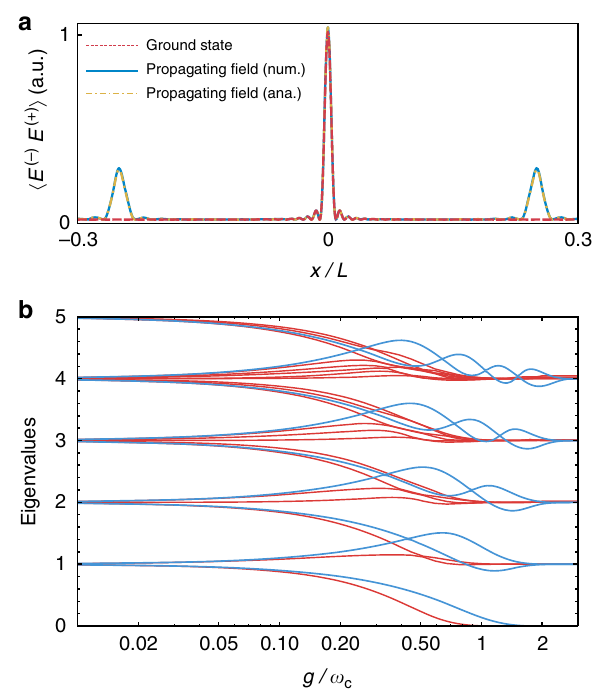
Fig. 4 Ground state and eigenvalues of the multi-mode Rabi model. a Red, dashed line: Amplitude of the electric fi eld inside the cavity corresponding to the ground state of the system for g / ω c = 0.6. Solid, blue (dashed- dotted, yellow): numerical (analytical) calculation of the electric fi eld for an dynamics of the system is given by the independent evolution of two freely propagating wavepackets plus a localized cloud of photons corresponding to the ground state of the light – matter system. b Low-energy spectrum of the single-mode (red) and multi-mode (blue) Rabi Hamiltonian as a function of the coupling rate. For each value of g , the eigenvalues are expressed with respect to the ground state. Here, ω x = ω